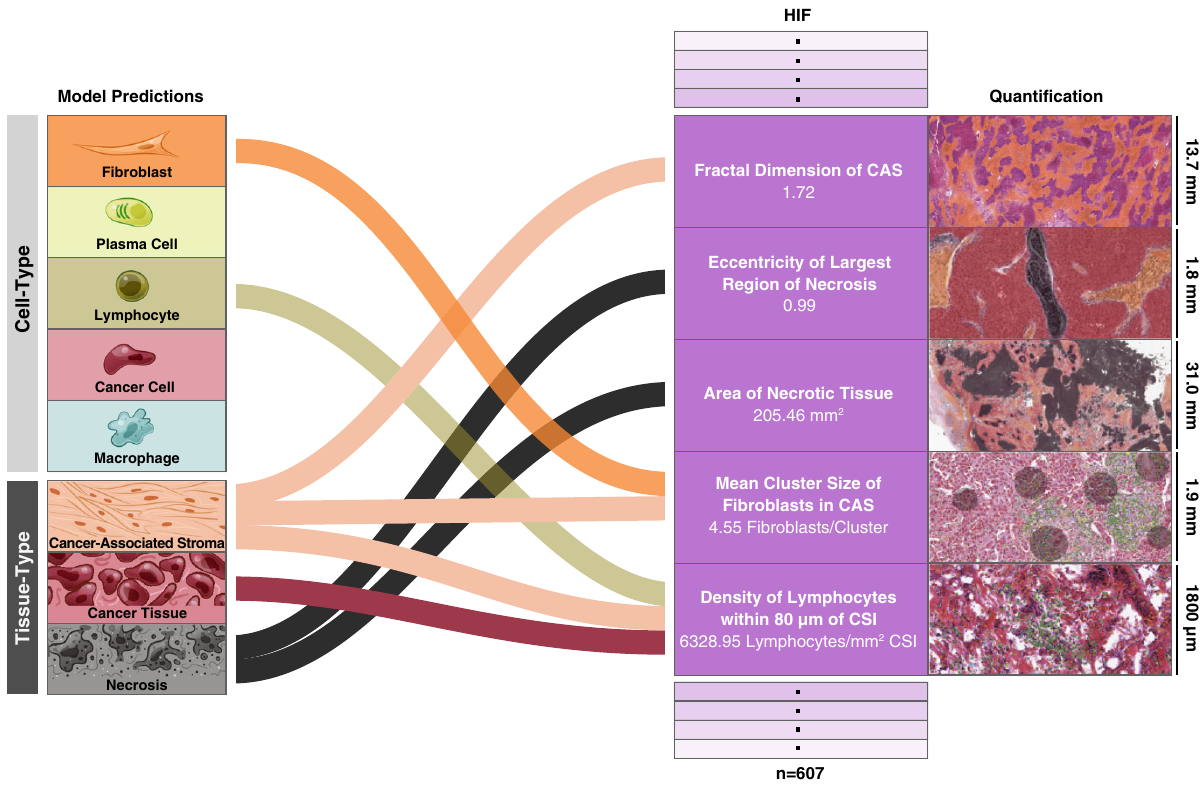
Fig. 2 Human-interpretable image feature extraction work fl ow. Flow diagram for extraction of human-interpretable image features (HIFs) from model predictions for fi ve example HIFs. For each HIF, a histological snapshot with the corresponding cell- or tissue-type heatmap overlaid and the associated quantity are shown. Histological snapshots have dimensions (from top to bottom, width by height) of 24,000 × 13,693, 3126 × 1785, 54,303 × 30,981, 3422 × 1953, and 3110 × 1800 μ m. Cell- and tissue-type color coding is the same as Fig.